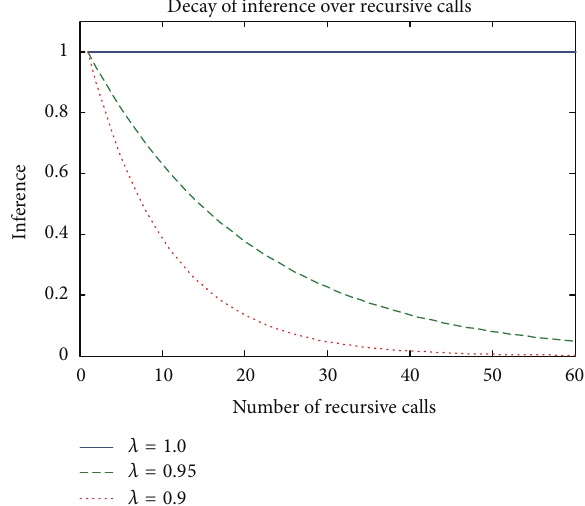
Figure 2: Decay of inference with a constant forgetting factor.